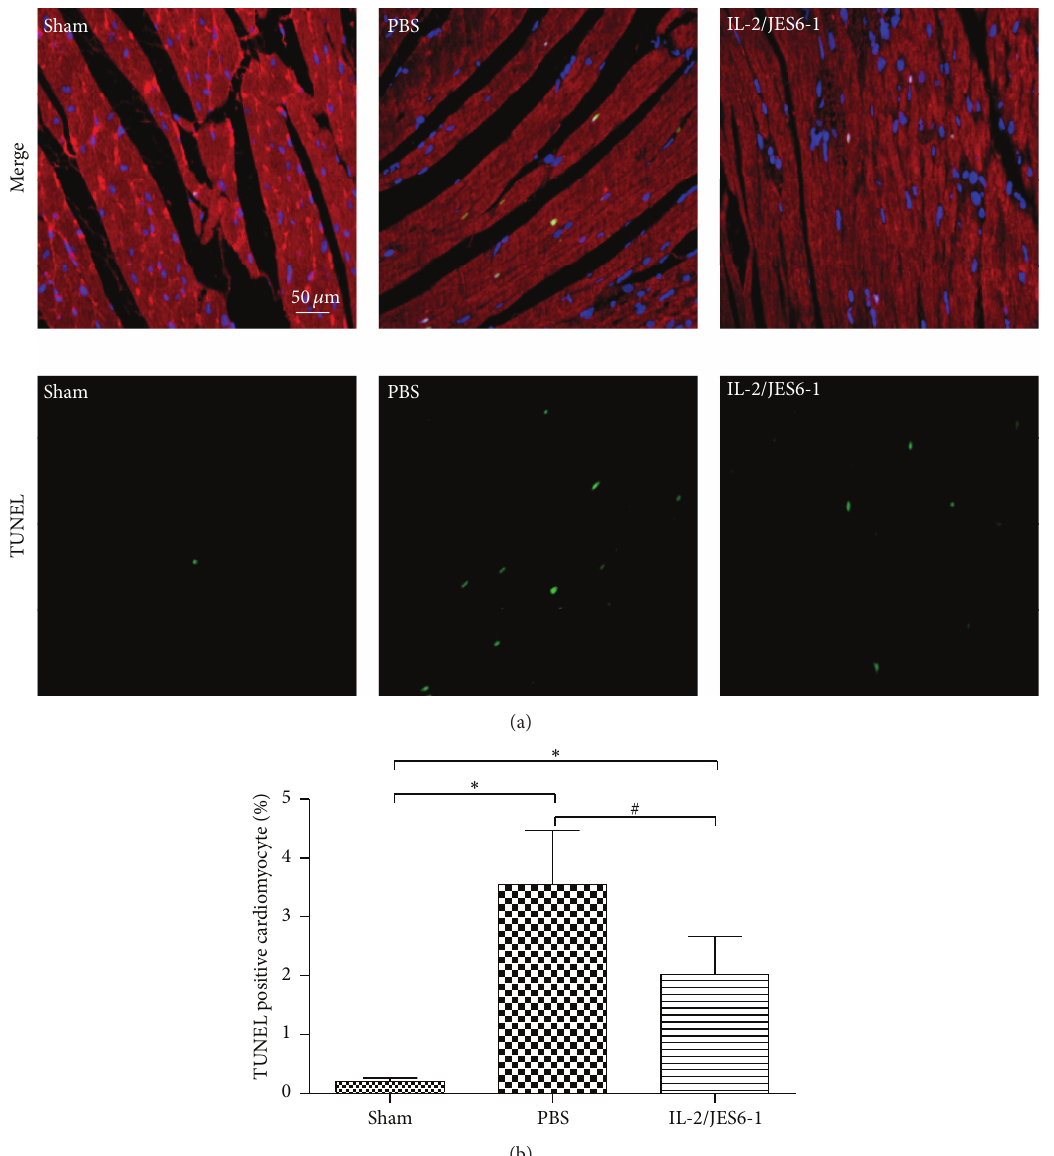
Figure 4: The IL-2/JES6-1 complex attenuates myocardial apoptosis after MI. (a) Representative images of TUNEL staining for myocardial apoptosis (green), DAPI (blue) for nuclear staining, and anti- 𝛼 -Actinin (red) for cardiomyocytes in peri-infarct zone on day 5 after MI. Original magnification × 400. (b) Quantitative analysis of percentages of TUNEL-positive nuclei ( 𝑛 = 6 per group). ∗ 𝑃 < 0.05 versus the Sham group, # 𝑃 < 0.05 versus the PBS